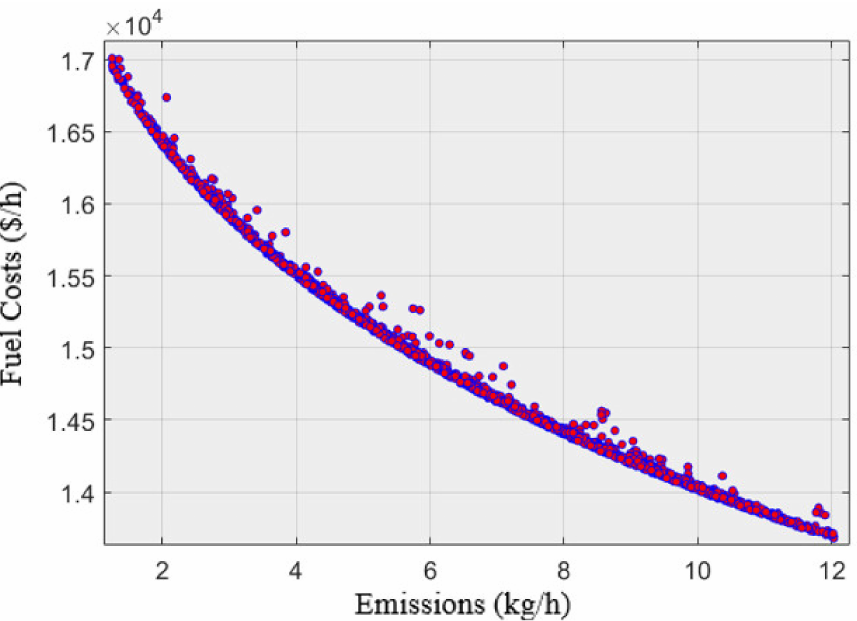
Figure 3. Development of Pareto set over the course of iterations with the proposed MTLSBA for the CHPEED problem.